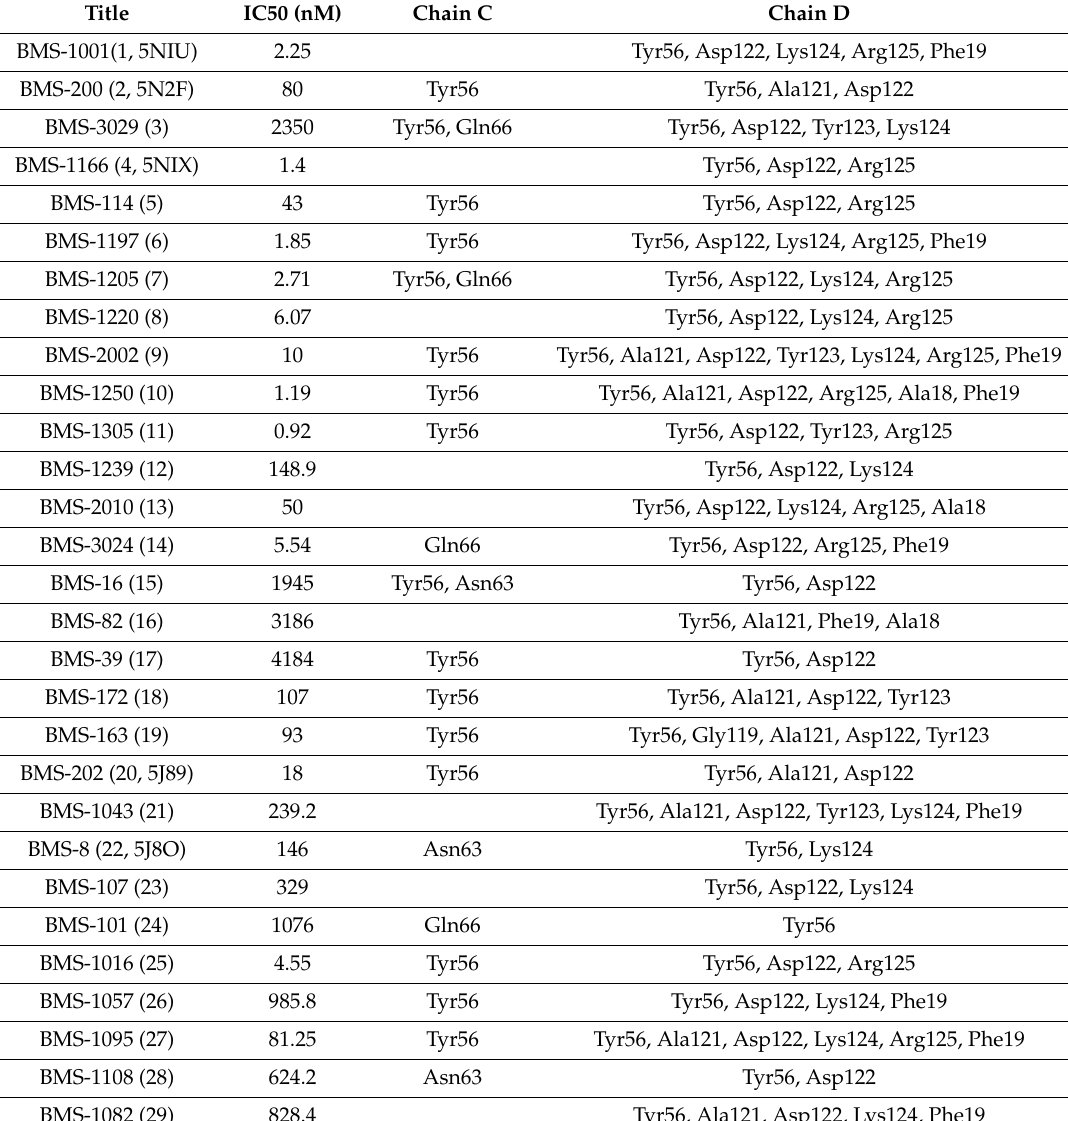
Table 1. The ligand–protein interactions between the PD-1 / PD-L1 complex inhibitors and the PD-L1 protein of